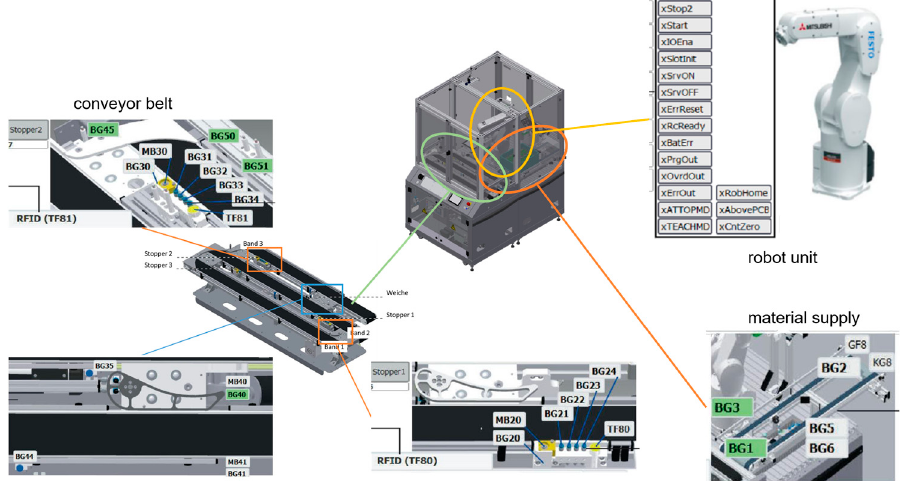
Figure 10. Robot assembly cell with signal sources (explosion-like representation).